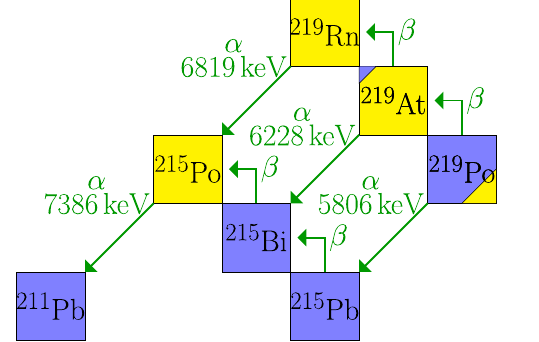
FIG. 17. α decay of 219 At (left) and 219 Po (right) with the information extracted from this work (see Table III) and Ref.